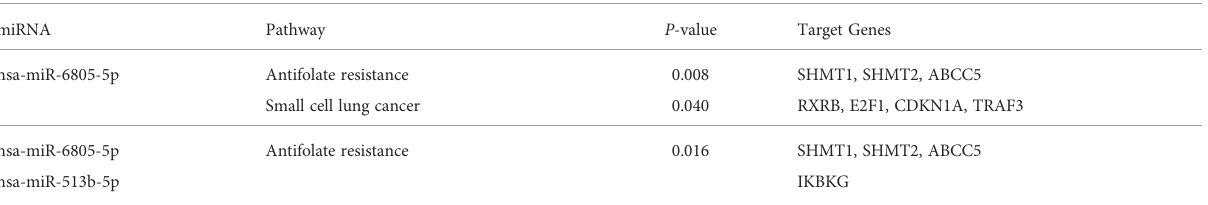
Pathway analysis results for PBMAH subtype2-speci fi c miRNAs: hsa-miR-631, hsa-miR-513b-5p, hsa-miR-6805-5p, and hsa-